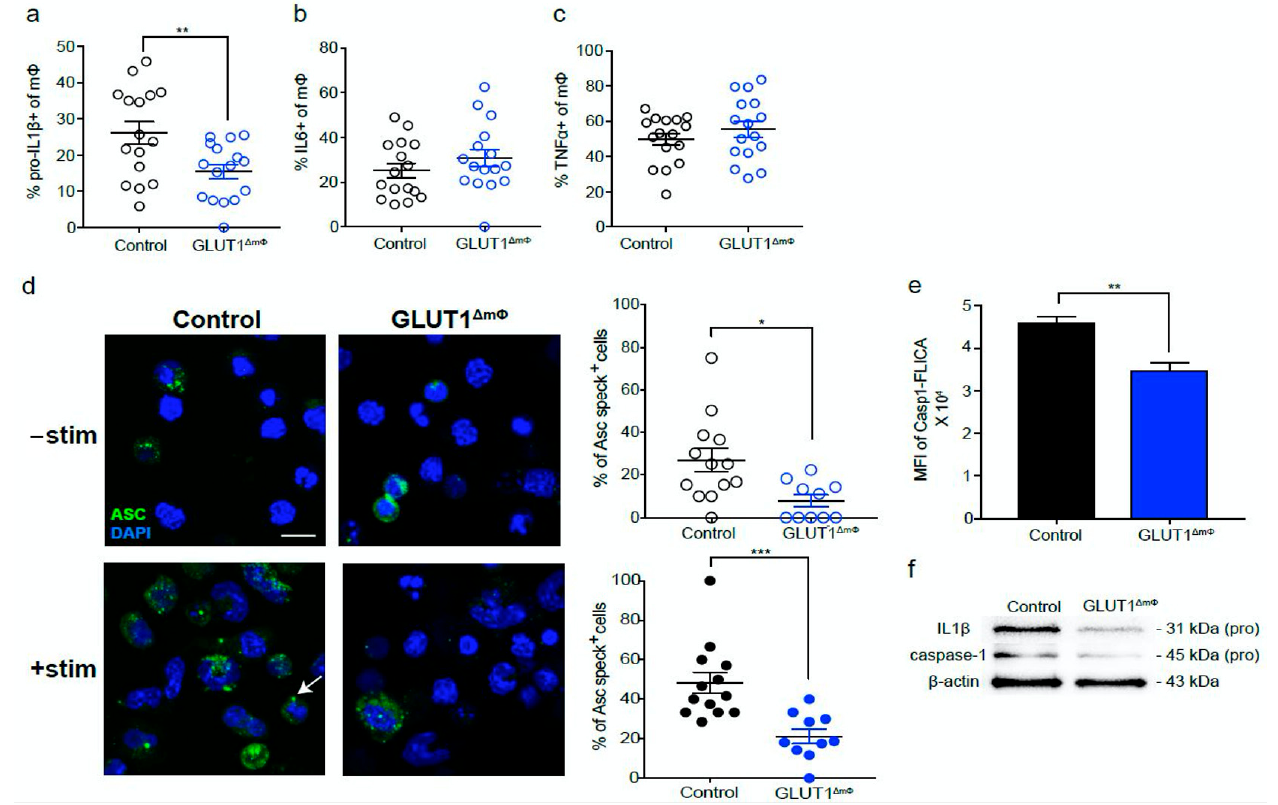
Figure 3. The pro-inflammatory NLRP3-IL1 β axis is suppressed in GLUT1 Δ m Φ macrophages. ( a – c ) Intracellular flow cytometry (ICFC) of pro-inflammatory cytokines was performed on control (black) and GLUT1 Δ m Φ (blue) pancreata cell suspensions restimulated with 100 ng/mL LPS for 4 h. Shown are scatter plots of the % pro-IL1 β + ( a ), % IL6+ ( b ), % TNF α + ( c ) of total macrophages (control, n = 16; GLUT1 Δ m Φ , n = 16, pooled from three independent experiments). Representative flow plots are shown in Supplementary Figure S3b. ( d ) Immunofluorescence staining of ASC specks was performed in FACS-sorted control (black) and GLUT1 Δ m Φ (blue) PEC macrophages stimulated with 1 μ g/mL of LPS for 3 h, and 10 μ M of nigericin for a further 30 min (+stim, bottom row) or without (-stim, top row). Shown are representative confocal images with nuclei (blue) and ASC (green) overlaid. Each ASC speck is identified as a dot-like perinuclear stain as shown by the representative white arrow in the bottom left image. Magnification bar = 10 μ M. Scatter plots shown are the quantification of % ASC speck+ cells for every field of view in unstimulated (open circles) and stimulated cells (filled circles) ( n = 3 mice pooled per group, two independent experiments). ( e ) FACS-sorted control (black) and GLUT1 Δ m Φ (blue) PEC macrophages were stained with Caspase-1-FAM-FLICA to assess caspase-1 activity by flow cytometry. Shown is a representative bar graph of the MFI of caspase-1 ( n = 3 mice pooled per group, two independent experiments). ( f ) Representative immunoblot of sorted control and GLUT1 Δ m Φ pancreatic tumor macrophage cell lysates probed for pro-IL1 β and pro-caspase 1 ( n = 6–8 mice pooled per group, two independent experiments). Data are means ± SEM, * p < 0.05; ** p < 0.01; *** p < 0.001; n.s. not significant, by unpaired student’s t-test with 95% confidence interval.